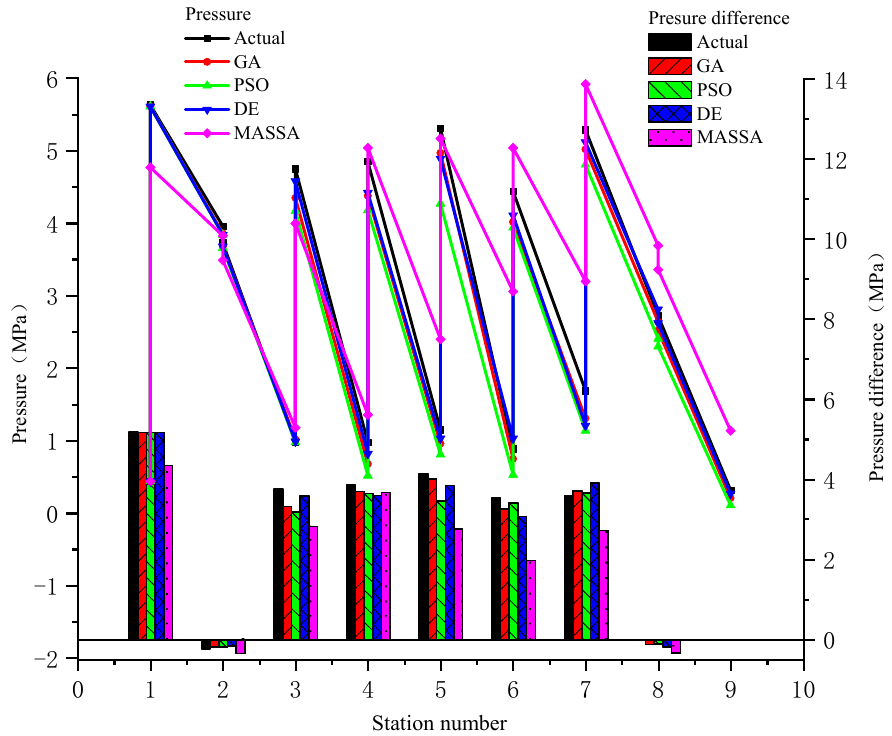
Figure 8. Pressure comparison between the actual scheme and the four algorithms’ simulation operation schemes.